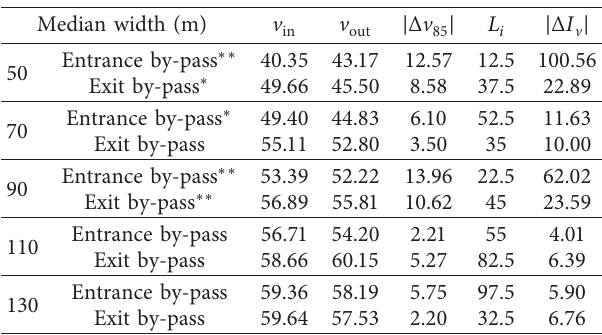
Figure 6: Vehicle speed changes with median width in (a) entrance by-pass and (b) exit by-pass. Table 4: | Δ I | distribution in entrance and exit by-pass among v different median